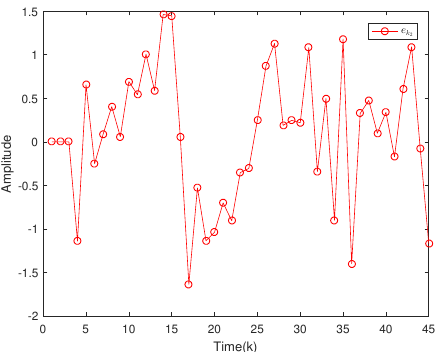
Figure 12. Filtering error e 2, k under the RAP scheduling.